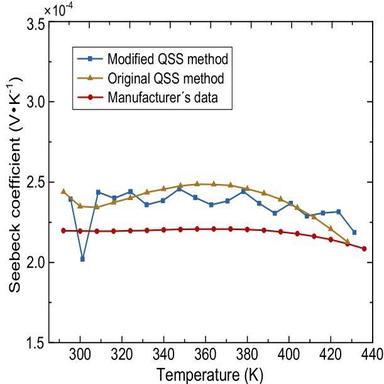
Comparison of the characterized temperature-dependent TEG parameters by the original and modified QSS methods, as well as the manufacturer's data.